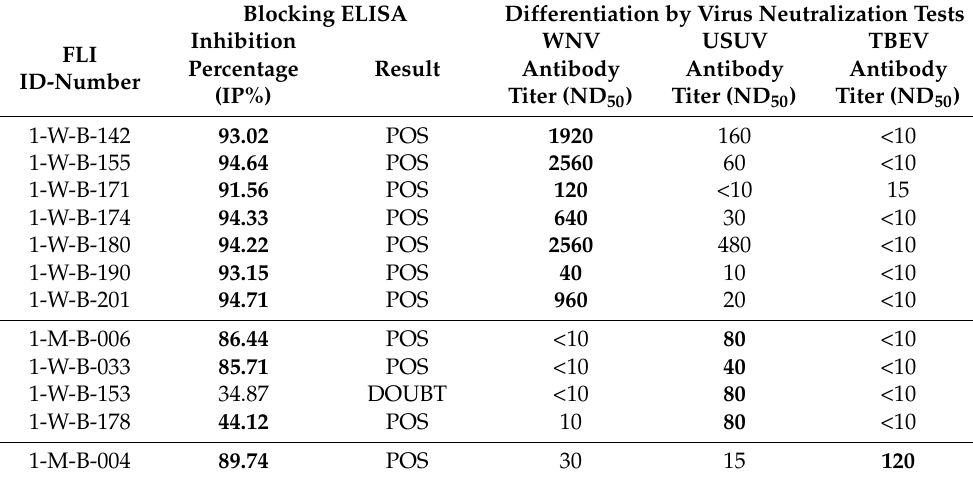
Table 4. Reactive flavivirus-ELISA results of raccoon/raccoon dog serum samples and differentiation between WNV, USUV and TBEV by neutralization tests. Samples were considered positive (POS) by blocking ELISA when the inhibition percentage (IP) was ≥ 40% and doubtful (DOUBT) by IP > 30% to <40% and IP ≤ 30% as negative (not shown). Positive ELISA and neutralization assay results are shown in bold; questionable ELISA results and cross-reacting antibody titers are also displayed.